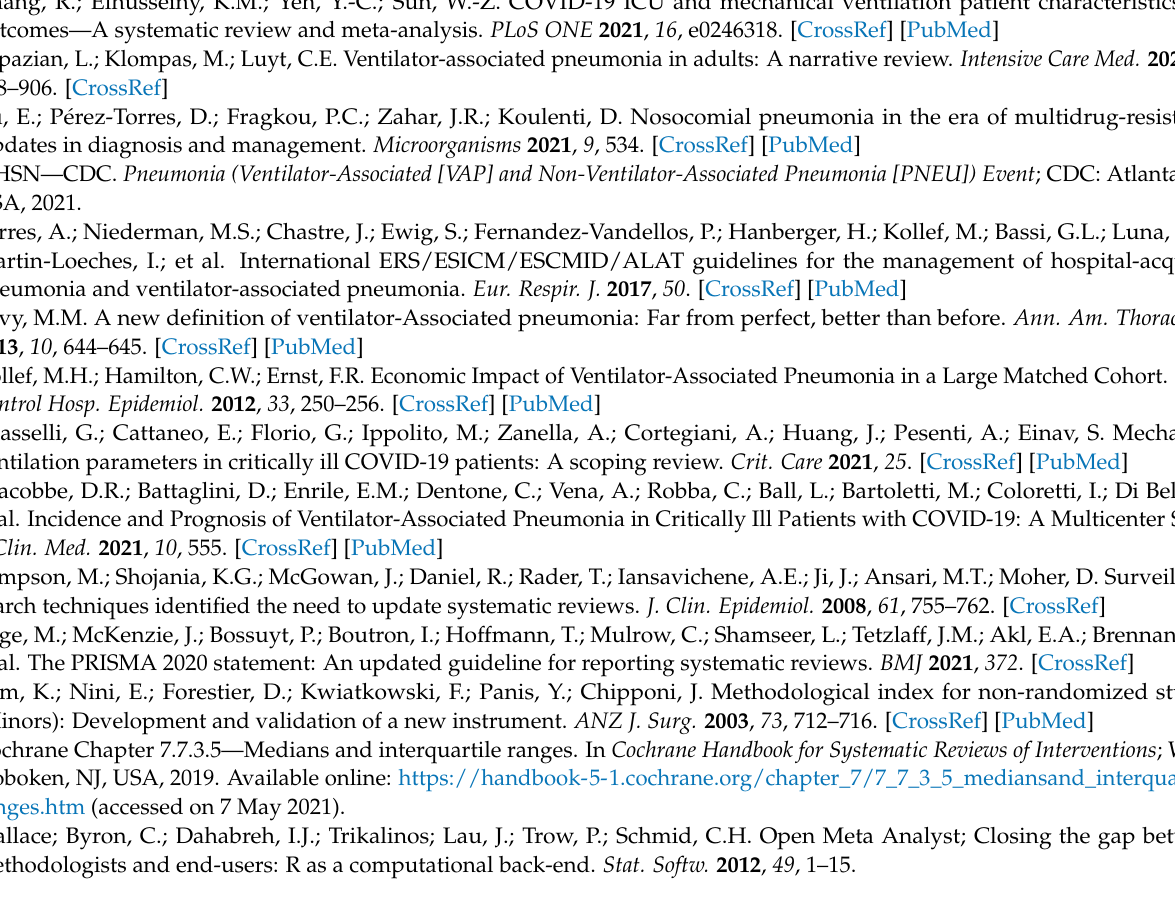
Figure S4: Forest plot with the results of the sensitivity analysis on the mortality of patients with COVID-19 and ventilator-associated pneumonia compared to patients with COVID-19 and admitted to ICU who did not develop ventilator-associated pneumonia; Figure S5: Forest plot with the results of the subgroup analysis conducted on the occurrence of ventilator-associated pneumonia in patients with COVID-19 in multicenter studies; Figure S6: Forest plot with the results of the subgroup analysis conducted on the occurrence of ventilator-associated pneumonia in patients with COVID-19 in Table S3: Quality assessment of studies according to MINORS score for non-comparative studies; Table S4: Quality assessment of studies according to MINORS additional score for comparative studies; Supplementary Material S3: Full search